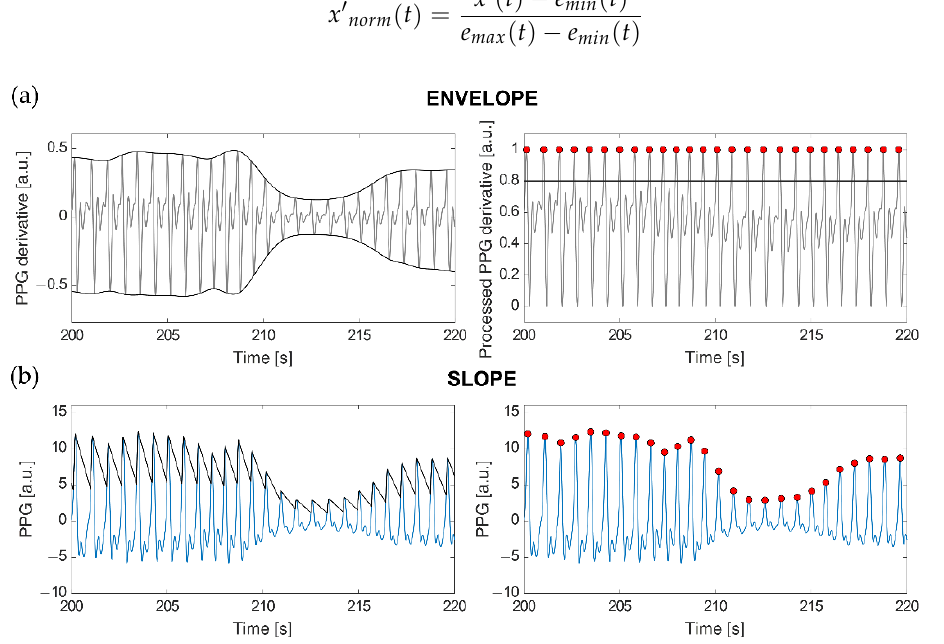
Figure 1. Application of the ENVELOPE ( a ) and SLOPE ( b ) beat detection methods to the respective signals of interest. ( a ) On the left, derivative of the PPG signal (grey) and relative superior and inferior envelopes (black); on the right, PPG derivative after subtraction of the inferior and superior envelopes (grey), threshold for peak detection (black line), and detected peaks (red circles). ( b ) On the left, the original PPG signal (light blue) and the computed adaptive threshold (black); on the right, detected peaks (red circles).